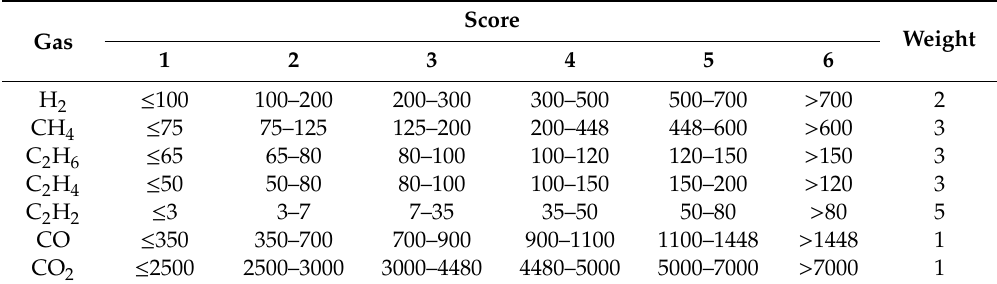
Table 1. Scoring and weight factors for gas levels (parts per million / ppm).